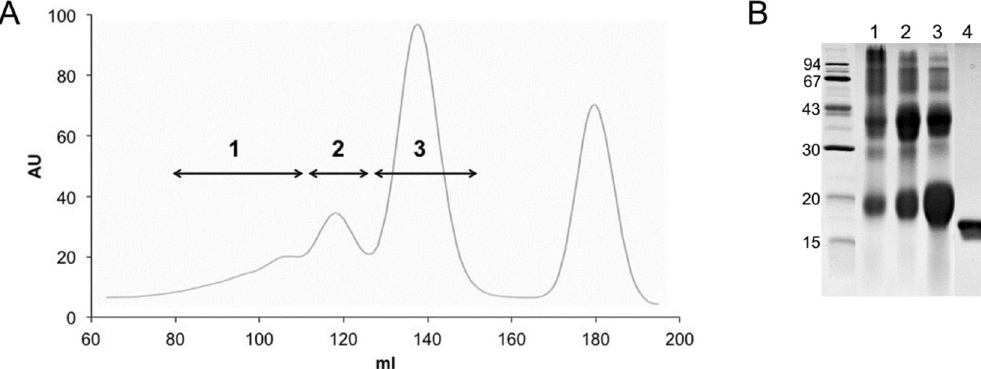
Figure 2. Fractionation of products obtained in HTG reaction of MB with mel (MAGEs fr. 1–3). ( A ) typical elution profile from a Sephadex G-200 column: tubes with eluted material were pooled as fractions 1–3 for analysis while low molecular mass material was ignored. ( B ) Products present in fraction 1, 2, and 3 (lane 1–3) and MB used for glycation (lane 4) were analyzed on 12.5% SDS-PAGE gel. The molecular mass of the reference standards is indicated on the left.